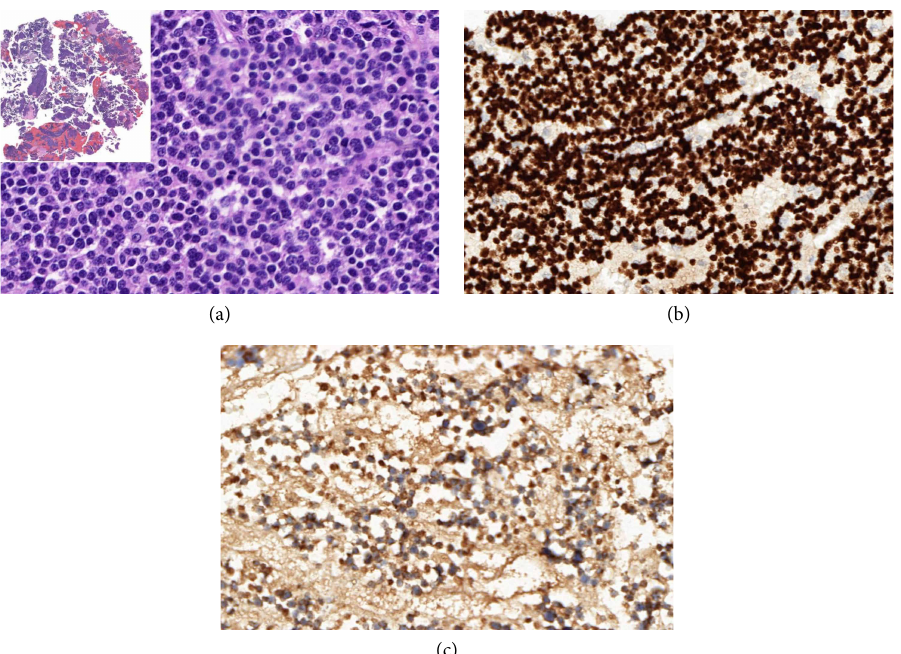
Figure 2: (a) (H&E, 400x and 20x). Right arm lesion biopsy. There are two images. The small one is a panoramic view with many fragments of the sample. The large one, with a high magnification, demonstrates the follicular aspect of the atypical cells. (b) (400x, TTF1). The neoplastic cells are positive for TTF1, indicating thyroid as a possibility of primary site for this case. (c) (400x, thyroglobulin). Besides the positivity for TTF1, the thyroglobulin pattern of positivity indicates thyroid as primary site of the